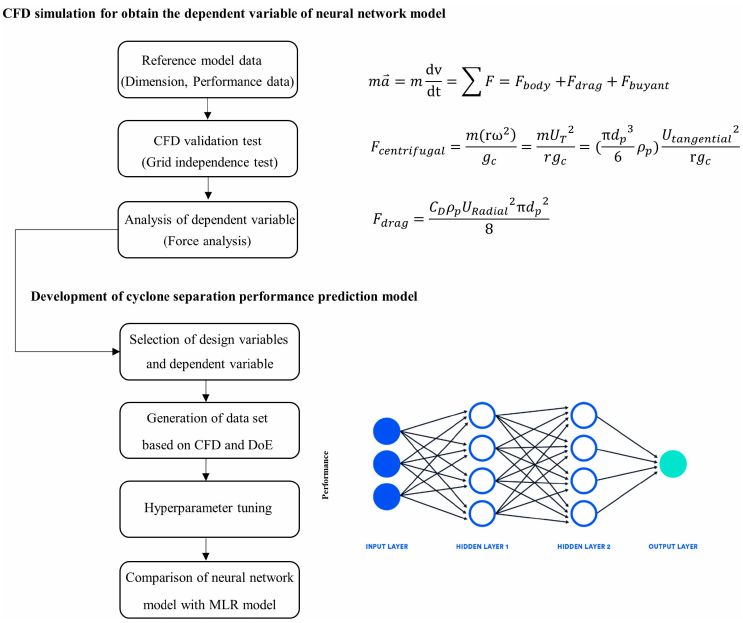
Figure 2. Research flow